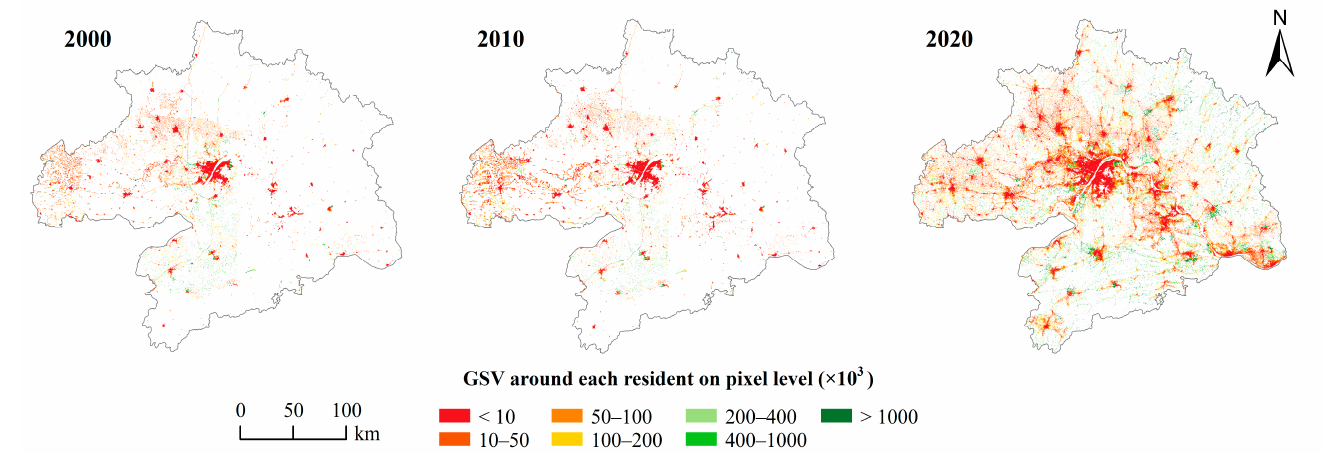
Figure 5. Distribution of the GSV available to residents.